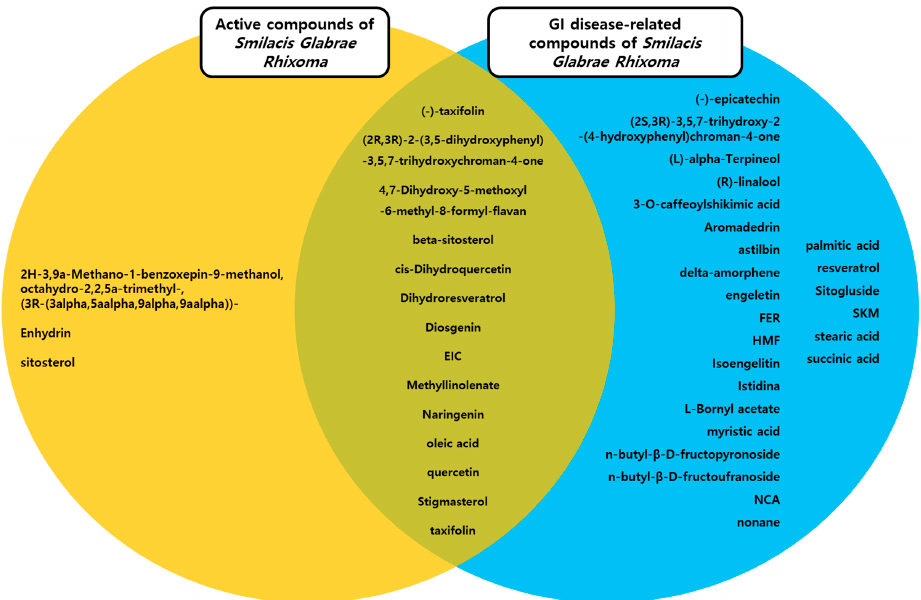
Figure 3. Active compounds and gastrointestinal (GI)-related compounds of SGR. The Venn dia- gram between active compounds and GI-disease-related compounds in SGR. SGR: Smilacis Glabrae Rhixoma.